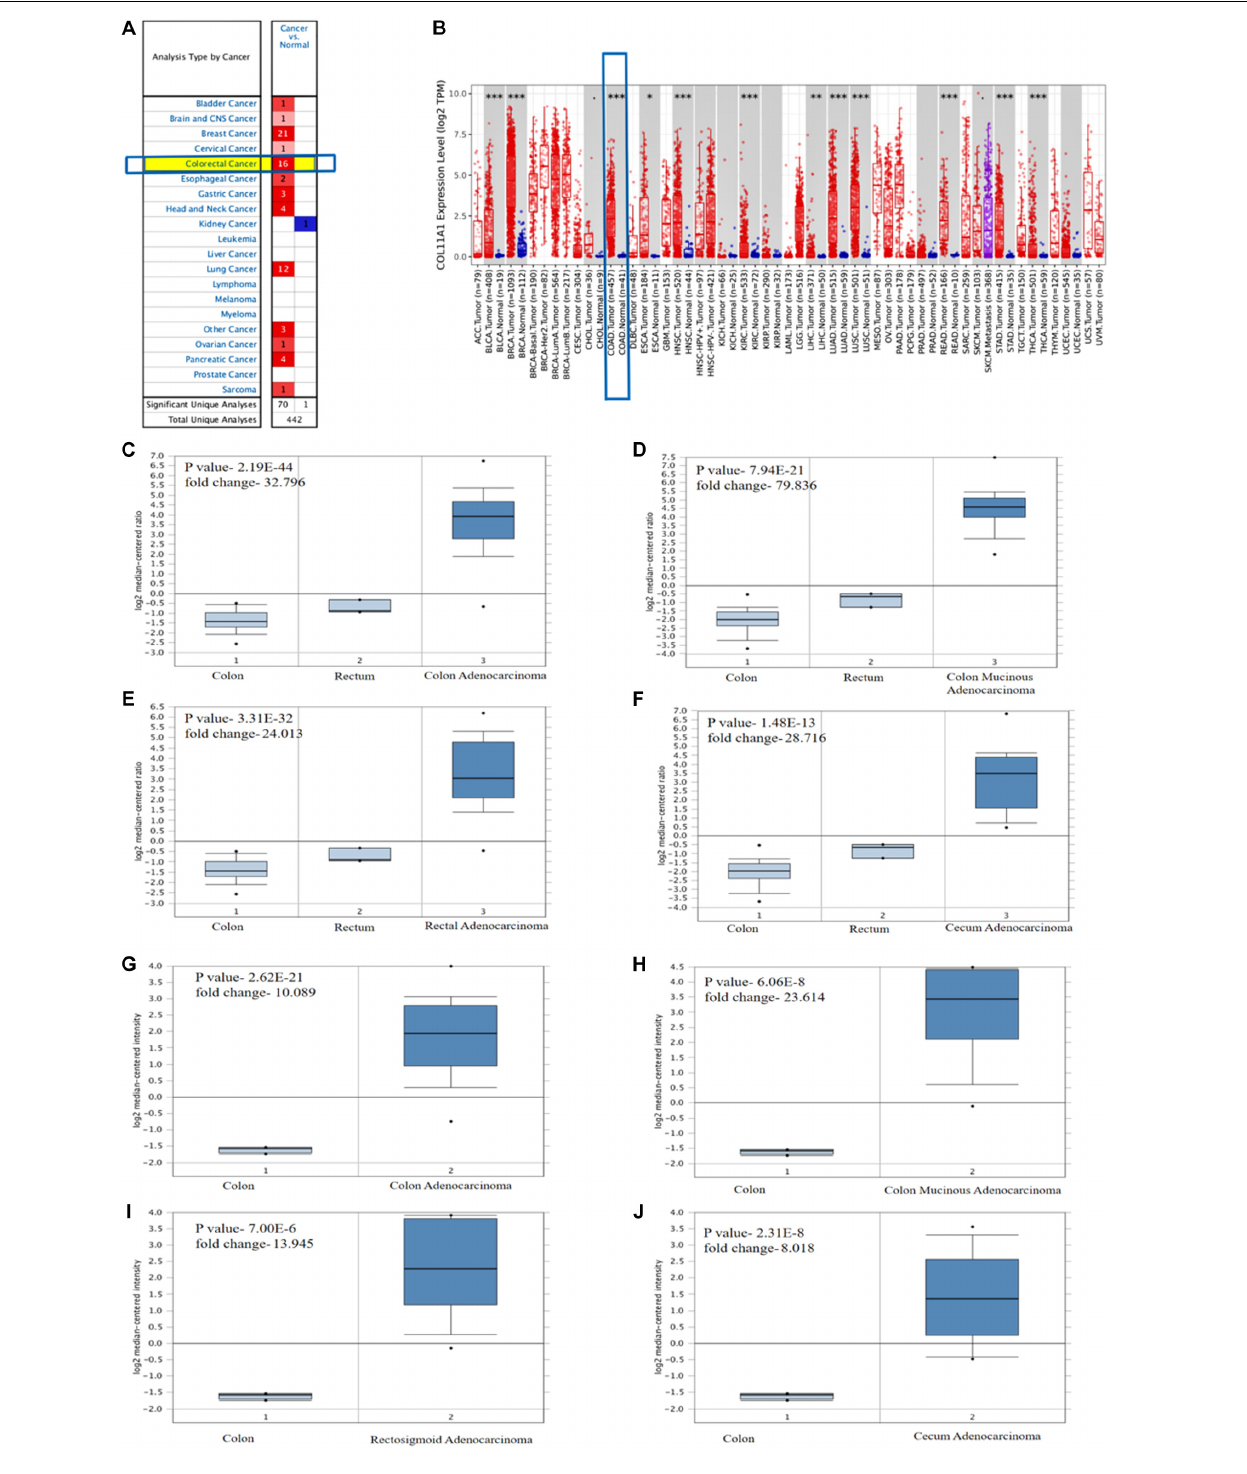
FIGURE 1 | Differential expression of COL11A1 gene (A) Expression of COL11A1 mRNA across different cancers where red and blue represent the upregulation and downregulation, respectively. (B) Comparative expression of COL11A1 mRNA between colon adenocarcinoma tumor tissue and normal tissue (statistical significance computed by differential analysis, ∗ P < 0.05; ∗∗ P < 0.01; ∗∗∗ P < 0.001). (C–F) Box plot comparison of COL11A1 expression for TCGA colorectal cancer dataset in panel (C) . Colon adenocarcinoma, (D) Colon Mucinous Adenocarcinoma, (E) Rectal Adenocarcinoma, (F) Cecum Adenocarcinoma. (G–J) Box plot comparison of COL11A1 expression for Kaiser colon cancer dataset in panel (G) . Colon adenocarcinoma, (H) Colon Mucinous Adenocarcinoma, (I) Rectosigmoid Adenocarcinoma, (J) Cecum Adenocarcinoma.